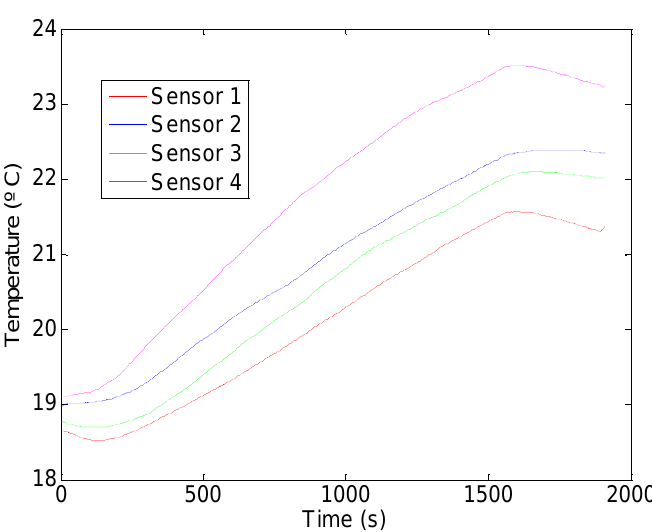
Figure 9. Temperature profile distribution in the